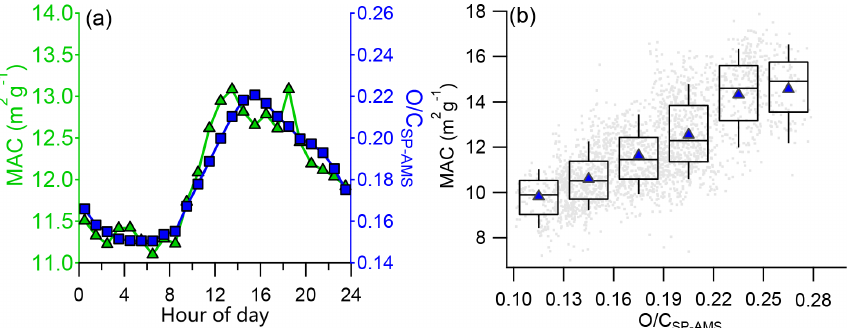
Figure 10. (a) Diurnal cycles of MAC and O / C ratio of SP-AMS (O / C SP-AMS ), and (b) variations of MAC as a function of O / C SP-AMS . The data are binned according to O / C. The median (horizontal line), mean (triangle), 25th and 75th percentiles (lower and upper box), and 10th and 90th percentiles (lower and upper whiskers) are also